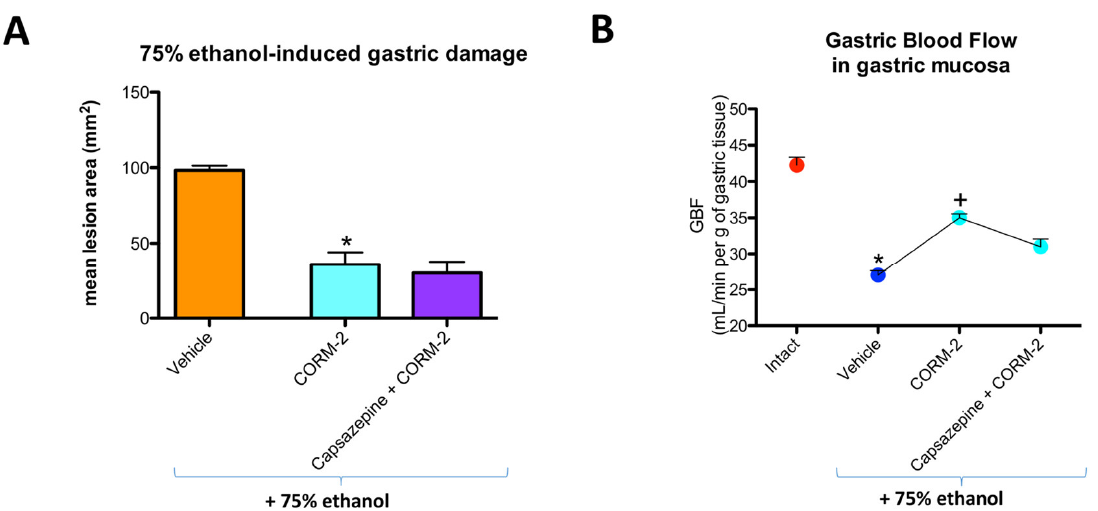
Figure 3. Mean area of 75% ethanol-induced gastric damage ( A ) and GBF ( B ) in rats pretreated with vehicle or CORM-2 (5 mg/kg i.g.) alone or in combination with capsazepine (5 mg/kg i.g.). Intact refers to healthy gastric mucosa, not exposed to 75% ethanol. Results are mean ± SEM of 4–5 rats per each experimental group. ( A ) Significant change as compared with the respective values in vehicle-control group was indicated by asterisk ( p < 0.05); ( B ) Significant change as compared with the respective values in intact gastric mucosa was indicated by asterisk ( p < 0.05); cross indicates significant change compared to the values obtained in the vehicle pretreated group ( p < 0.05).